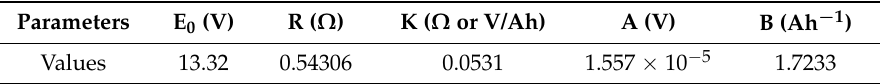
Table 1. Battery’s Table 1. Battery’s parameters.